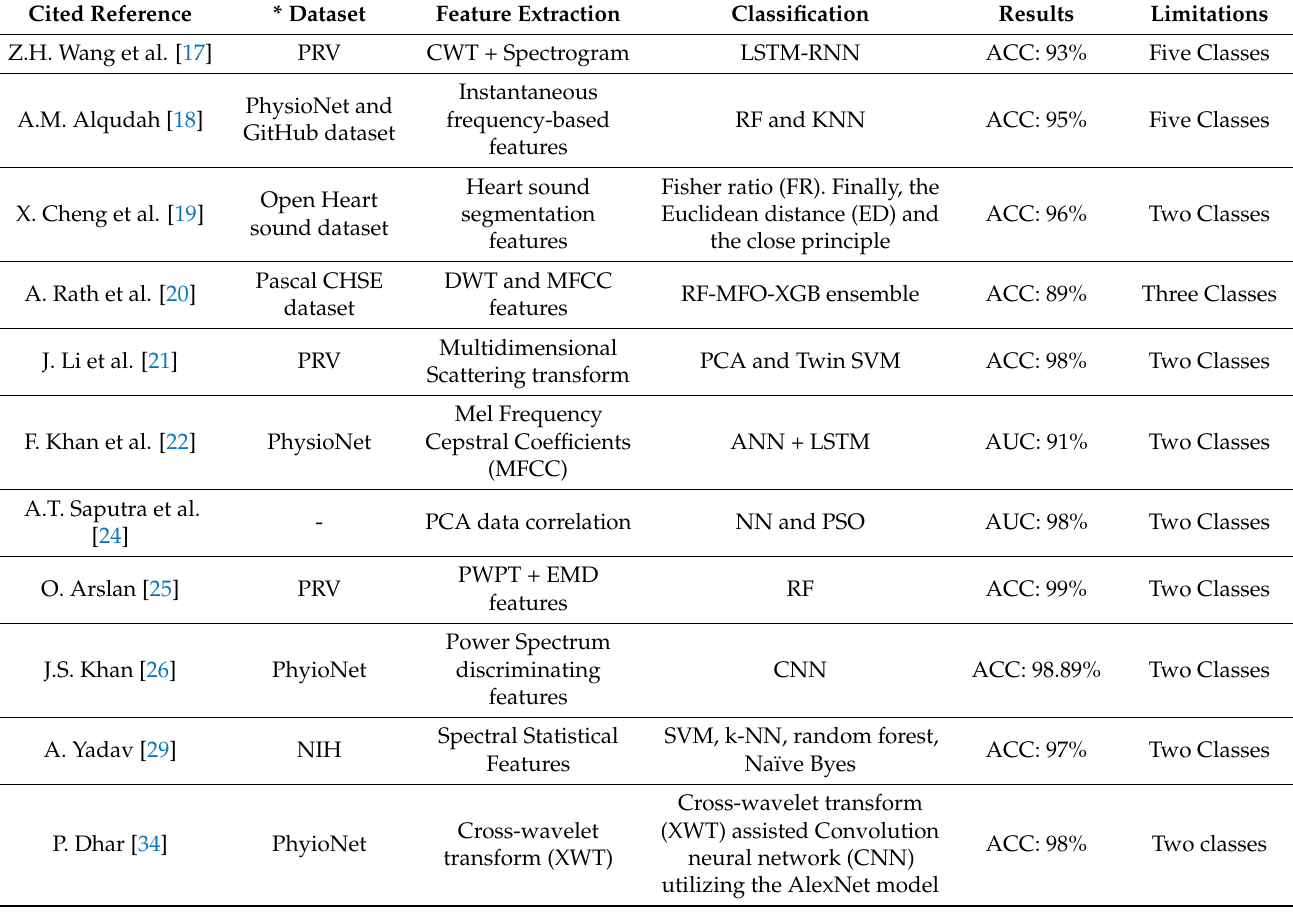
Table 1. A Comparative performance of existing work for cardiac disease classification